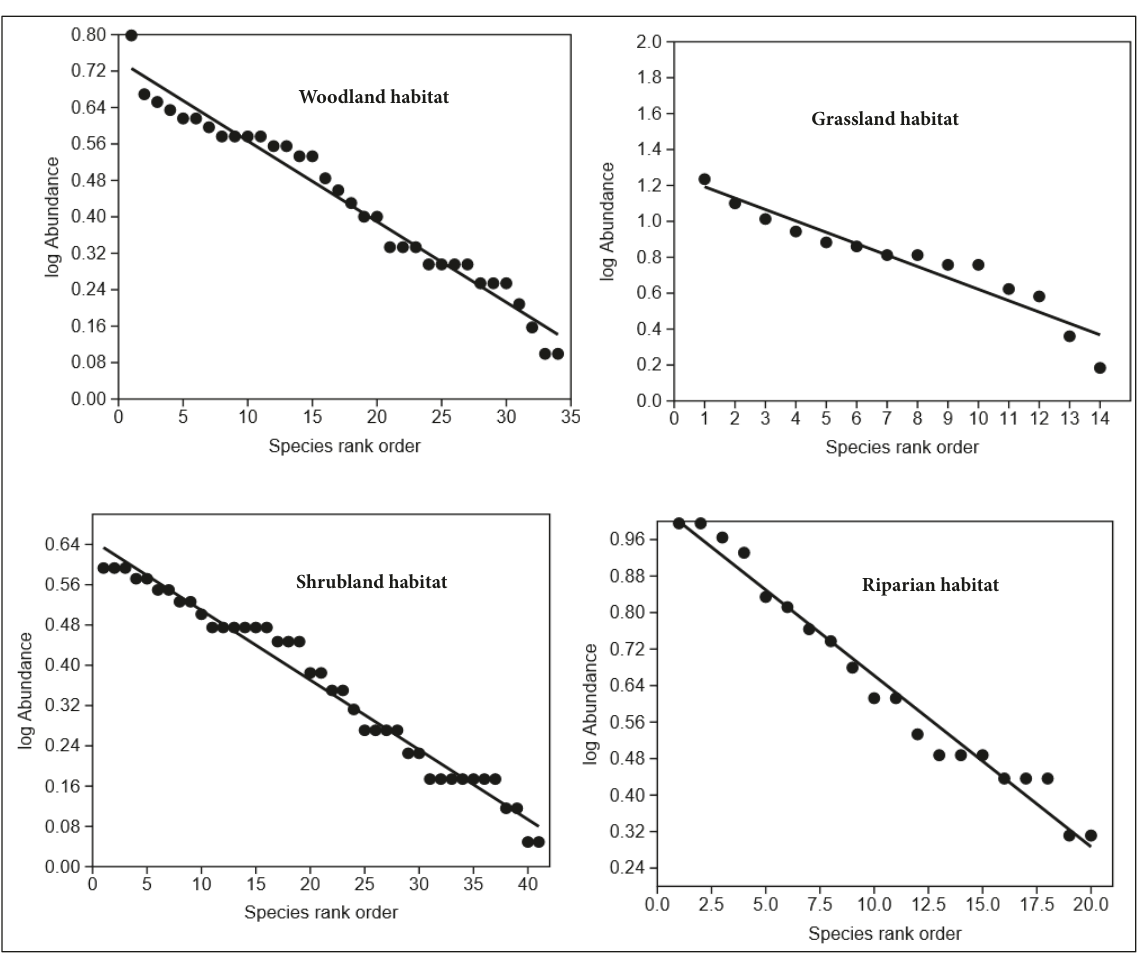
Figure2:GeometricmodelforbirdrankabundancedistributionacrossthefourhabitatsinMoleNationalPark,inthedry season.Abundance is based on cumulative cover values per species per test site. Notice that SADs are ordered in a decreasing magnitude and plotted against the corresponding rank in this